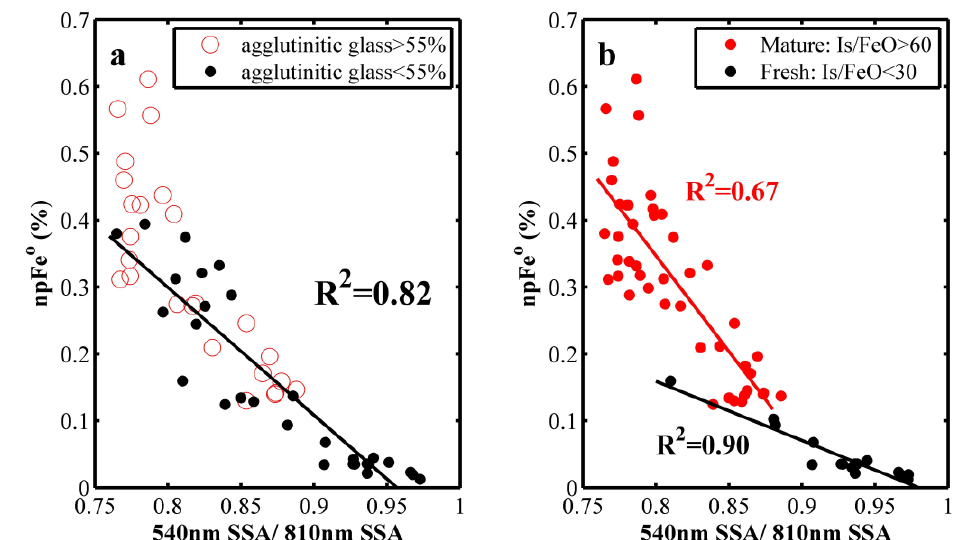
Figure 12. ( a ) Correlation between the ratio of 540 nm SSA/810 nm SSA and npFe 0 for lunar soil samples with agglutinitic glass content < 55%. Red circles are soil samples ignored in the regression process with agglutinitic glass content > 55%; ( b ) Correlation between the ratio of 540 nm SSA/810 nm SSA and npFe 0 for mature (red dots and line) and fresh (black dots and line) lunar soil samples.